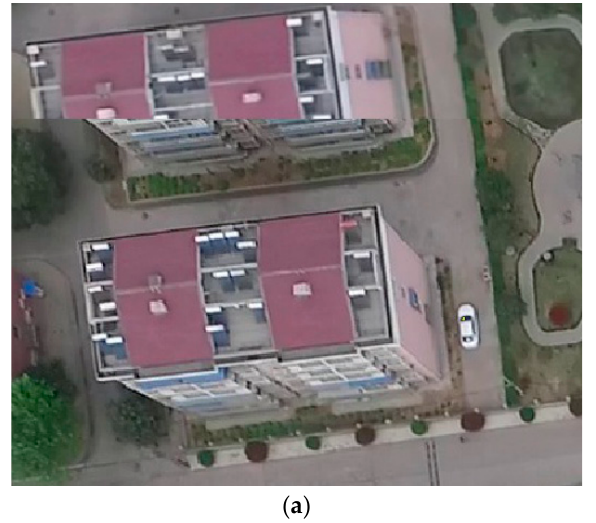
Weight substitution. ( d ) Our method.